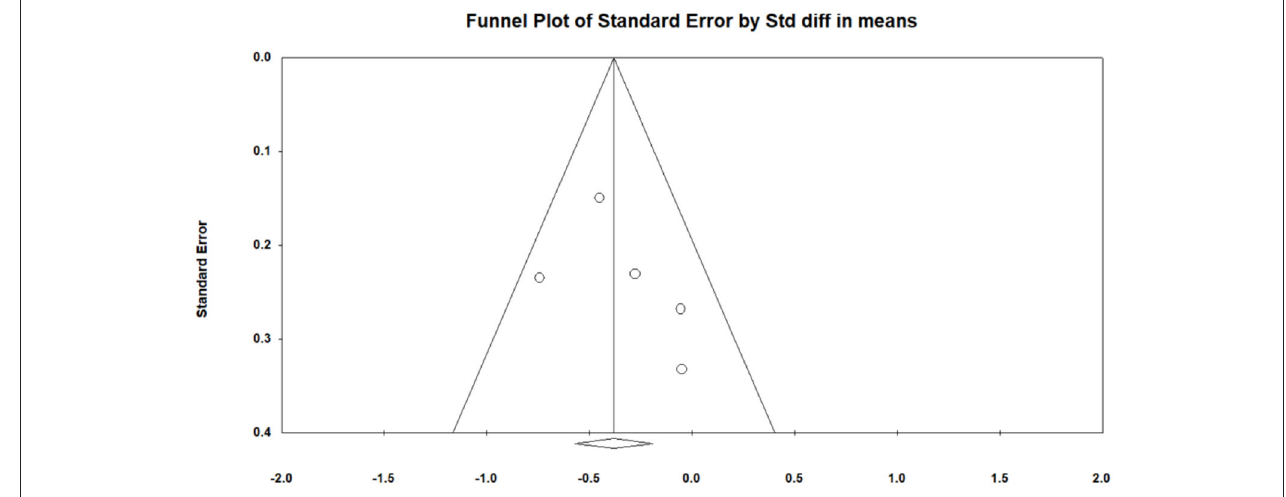
FIGURE 6 | Funnel plot for depression.